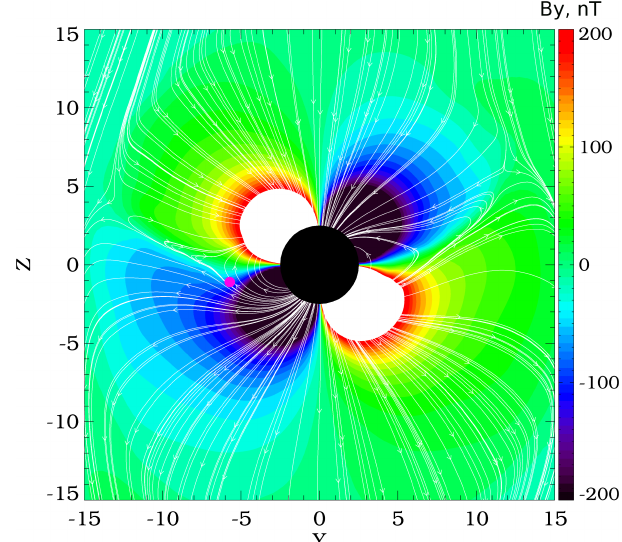
Figure 6. Color isocontours of model B y (nT) in the GSM YZ plane ( x = 0) at 04:00UT together with magnetic lines projected to the plane. Van Allen Probe A near 04:00UT has the following GSM XYZ coordinates: 0.0; − 5.65; − 1.17 R E . The location of Probe A is denoted by the magenta circle. The effect of a thinner current sheet in the dawn sector is the effect of projection onto the YZ plane. These field lines are highly stretched in the tailward direction and appear near the OCB